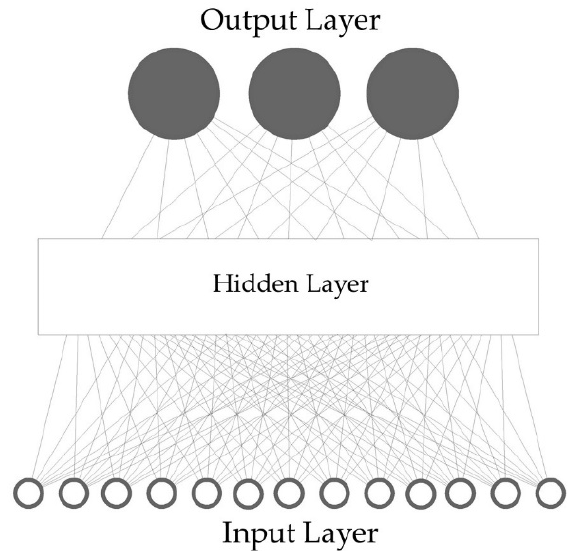
Figure 3. Structure and topology of the artificial neural network pattern-recognition algorithms.